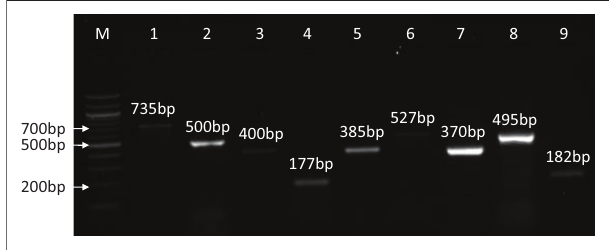
FIGURE 1: Representative gel picture of species identification and virulence genes investigated from Campylobacter spp.